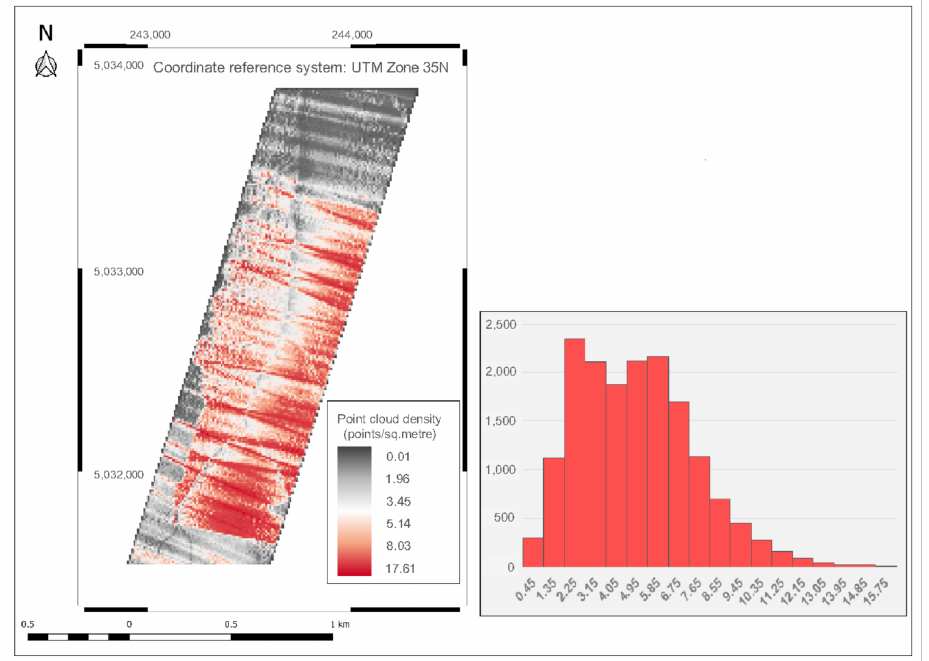
Figure 2. Spatial and frequency distribution of the initial LiDAR point cloud. The point density grid was generated at a 10 m resolution, to reduce the amount of